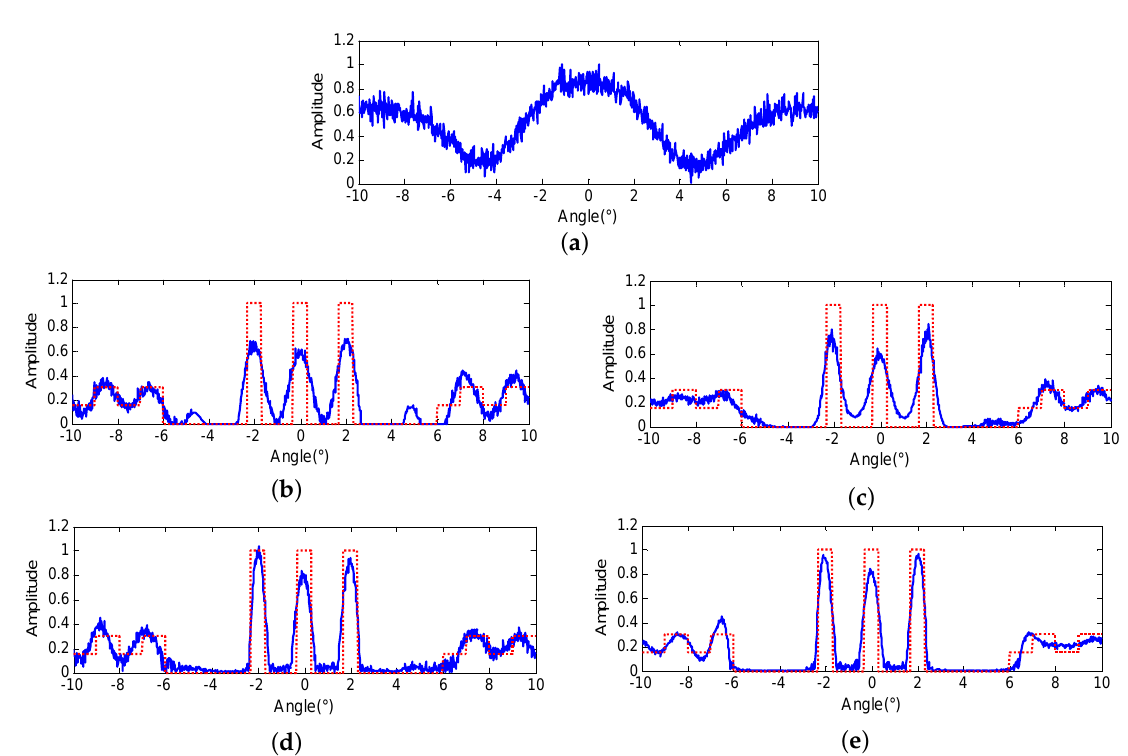
Figure 3. Super-resolution results comparison in the case of SNR = 20 dB ( a ) echo super-resolution results of ( b ) Landweber ( c ) Richardson-Lucy (RL) ( d ) maximum a posterior (MAP) ( e ) proposed penalized maximum likelihood